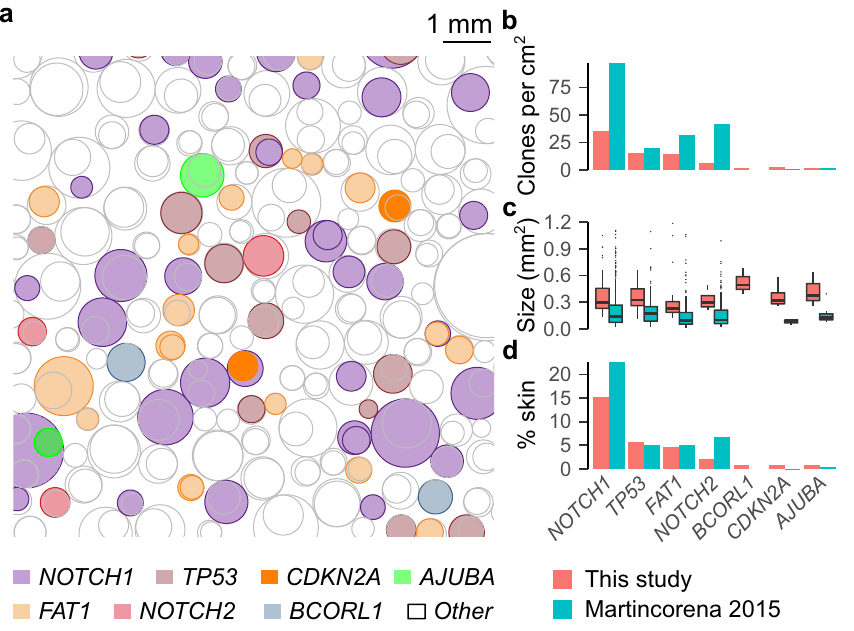
Figure 4. Clonal alterations in healthy UV-exposed skin. ( a ) Visualization of the estimated number and size of somatic mutation-driven clones in 1 cm 2 healthy skin. Data from PM01 and PM02 pooled. Clones driven by genes for which positive selection signals were found in this study are colored as indicated in bottom legend. Other clones are uncolored. Clones were positioned randomly with clone sizes and frequency based on data from this study. ( b – d ) Comparison of ( b ) clone frequency (number per cm 2 ), ( c ) clone size and ( d ) estimated percentage of skin occupied by each clone between this study and the study from Martincorena 2015 for genes for which positive selection signals were